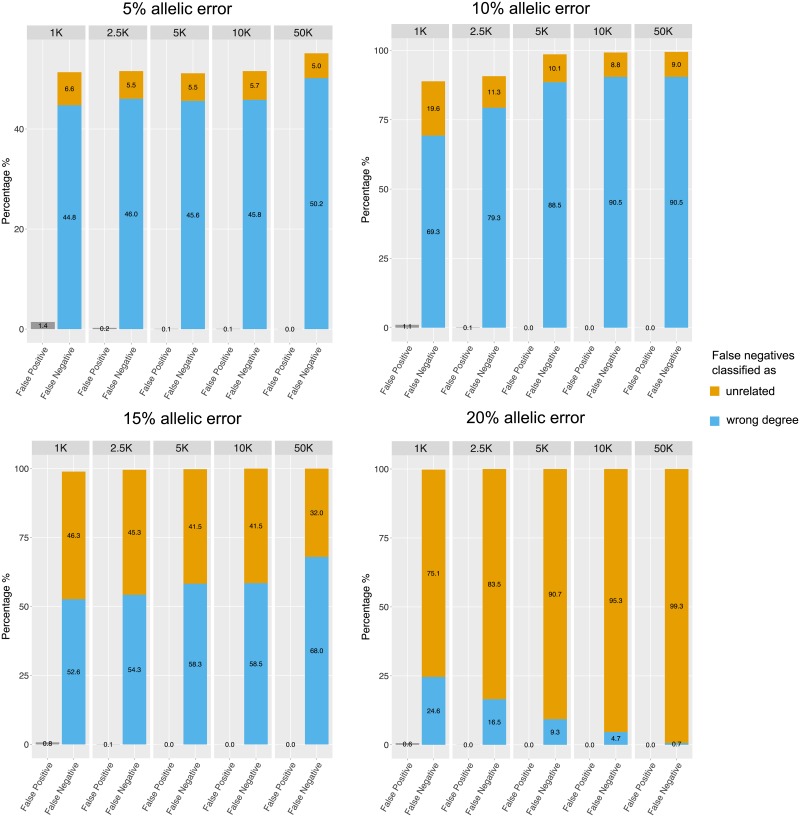
Effect of allelic errors on READ’s performance.The simulations are identical to those conducted for Fig 2 but including a certain proportion of wrongly called alleles. The rates of false positives and false negatives were calculated accordingly. Error rates were estimated for 1,000, 2,500, 5,000, 10,000 and 50,000 overlapping SNPs between the pair of individuals.